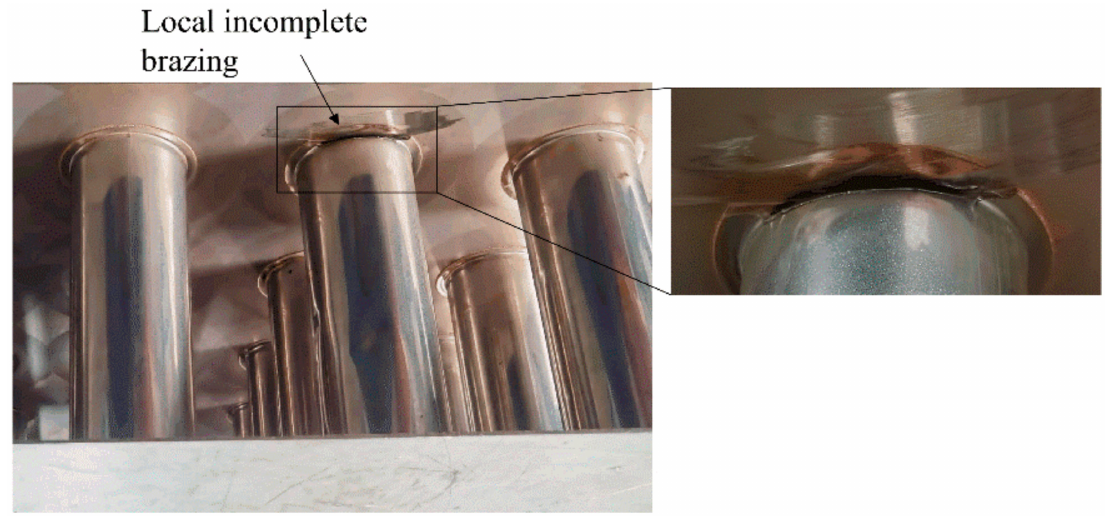
Figure 2. SS core panel specimen with a prefabricated local incomplete brazing